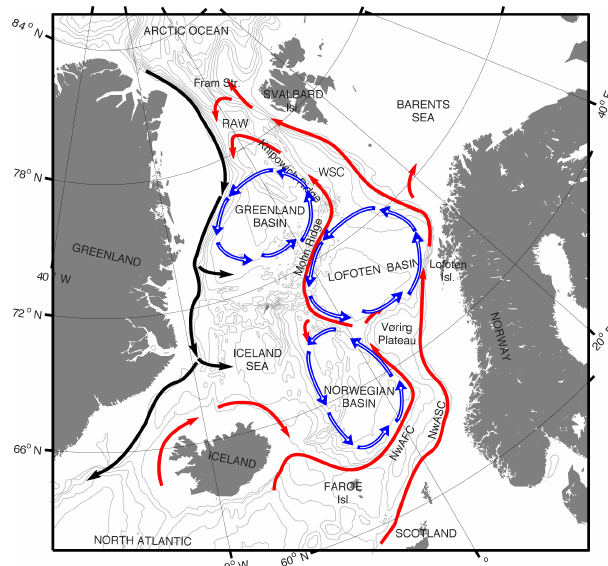
Figure 1. The Nordic Seas with schematic water pathways showing the northward flowing Atlantic Water in the surface (red) and south- ward flowing East Greenland Current (black). The two branches of the Norwegian Atlantic Current, the Norwegian Atlantic slope current (NwASC) and Norwegian Atlantic front current (NwAFC) are represented by red arrows. The cyclonic gyre circulations in the Norwegian Basin, Lofoten Basin and Greenland Basin are indicated in blue. See Chatterjee et al. (2018) and Raj et al. (2015) for details. Grey isobaths are drawn for every 600m. The location of the Arc- tic Front in the Norwegian Sea coincides with the location of the